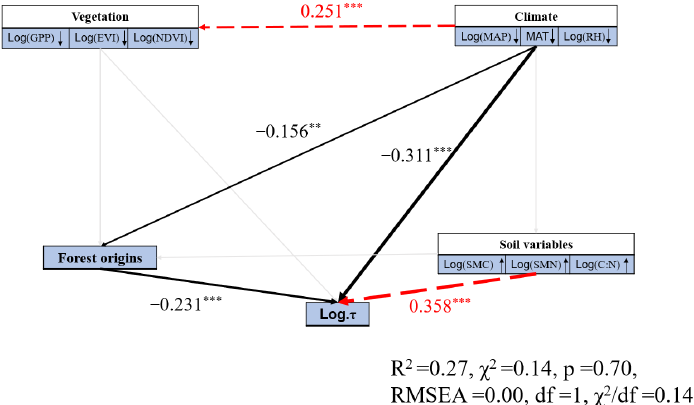
Figure A13. The main influencing factors of C turnover on the subsoil of NBF were obtained by the SEM model. The symbols “ ↑ ” and “ ↓ ” indicate a positive or negative correlation between environmental factors and subsoil τ . The goodness of fit statistics for the effect size model of the relationship are as follows: *** p < 0.001.